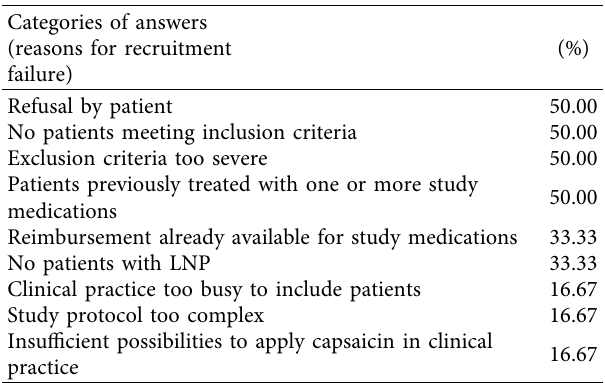
Table 2: Main reasons for recruitment failure in the PELICAN study, as collected during the qualitative study that was performed after the closure of the pragmatic study. Te mentioned reasons are displayed in descending order of importance, as indicated by the surveyed pain